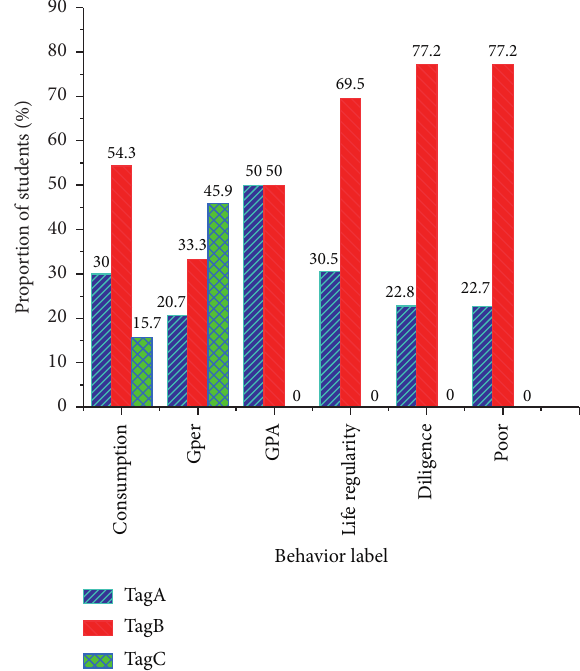
Figure 2: Label distribution. Table 10: 2-item